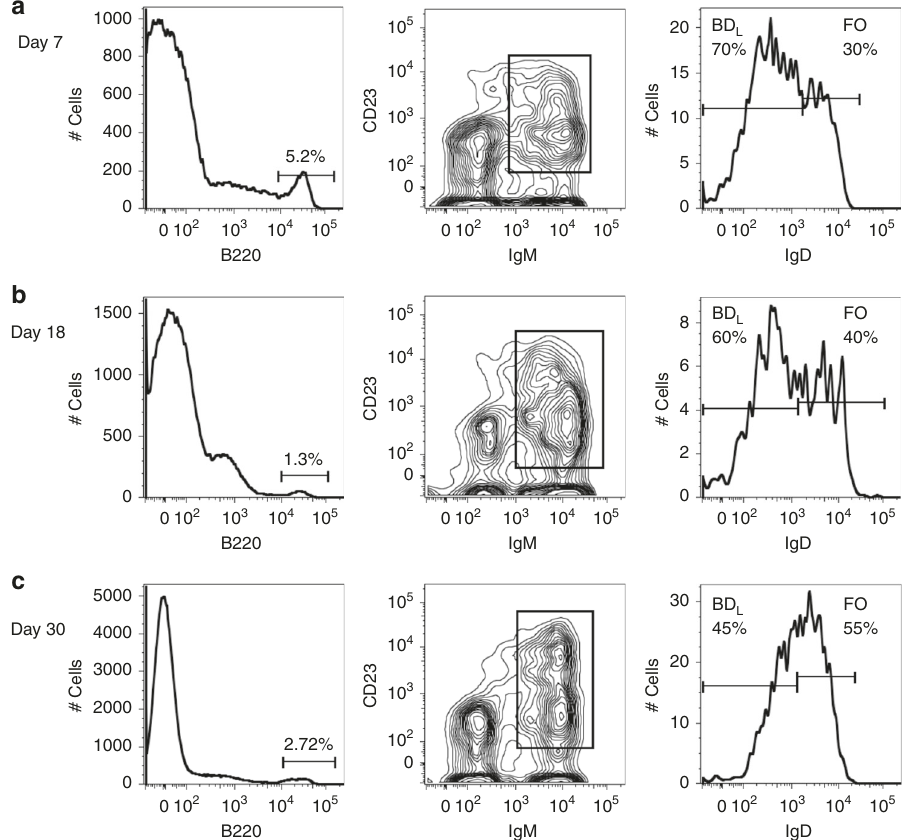
Fig. 8 Following adoptive transfer and EAE induction BD L are stable up to 30 days. BD L adoptive transfer and EAE was performed as for Fig. 3c and the data are from the same mice used for Fig. 3d, e. On days 7 ( a ), 18 ( b ), and 30 ( c ) of EAE, B220 + lymphocytes were gated for IgM + CD23 + and analyzed for IgD expression by fl ow cytometry. The percentage of BD L and FO B cells is provided. Data shown are one representative mouse of